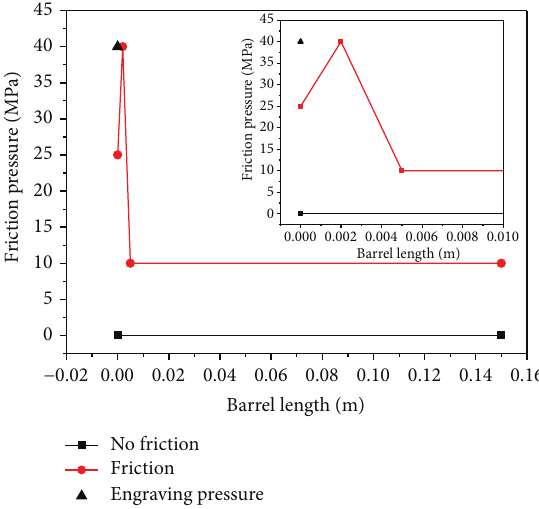
Figure 9: Friction pressure inside the